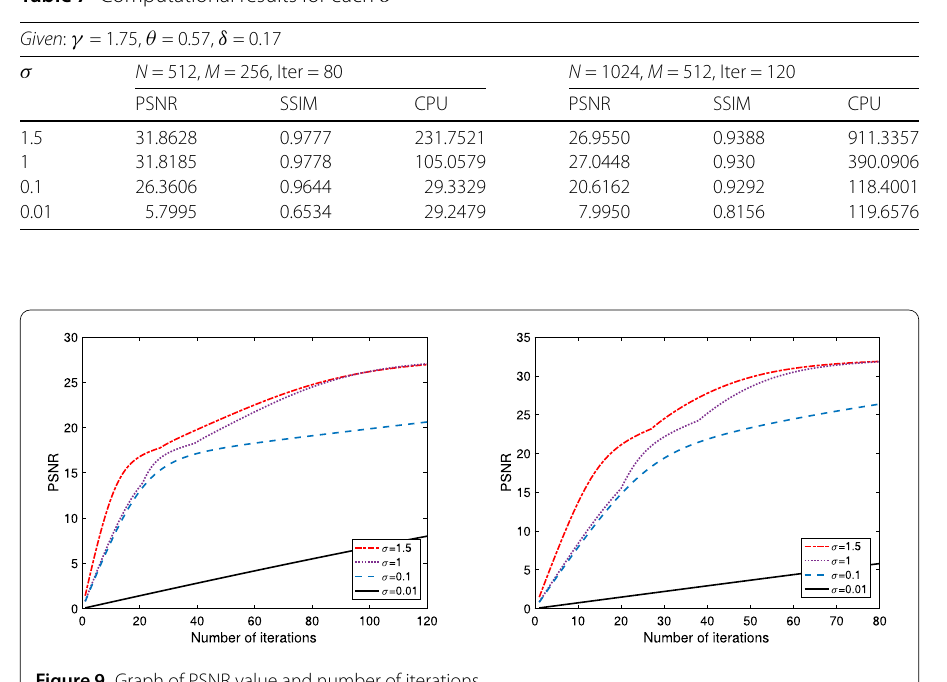
Figure 9 Graph of PSNR value and number of iterations